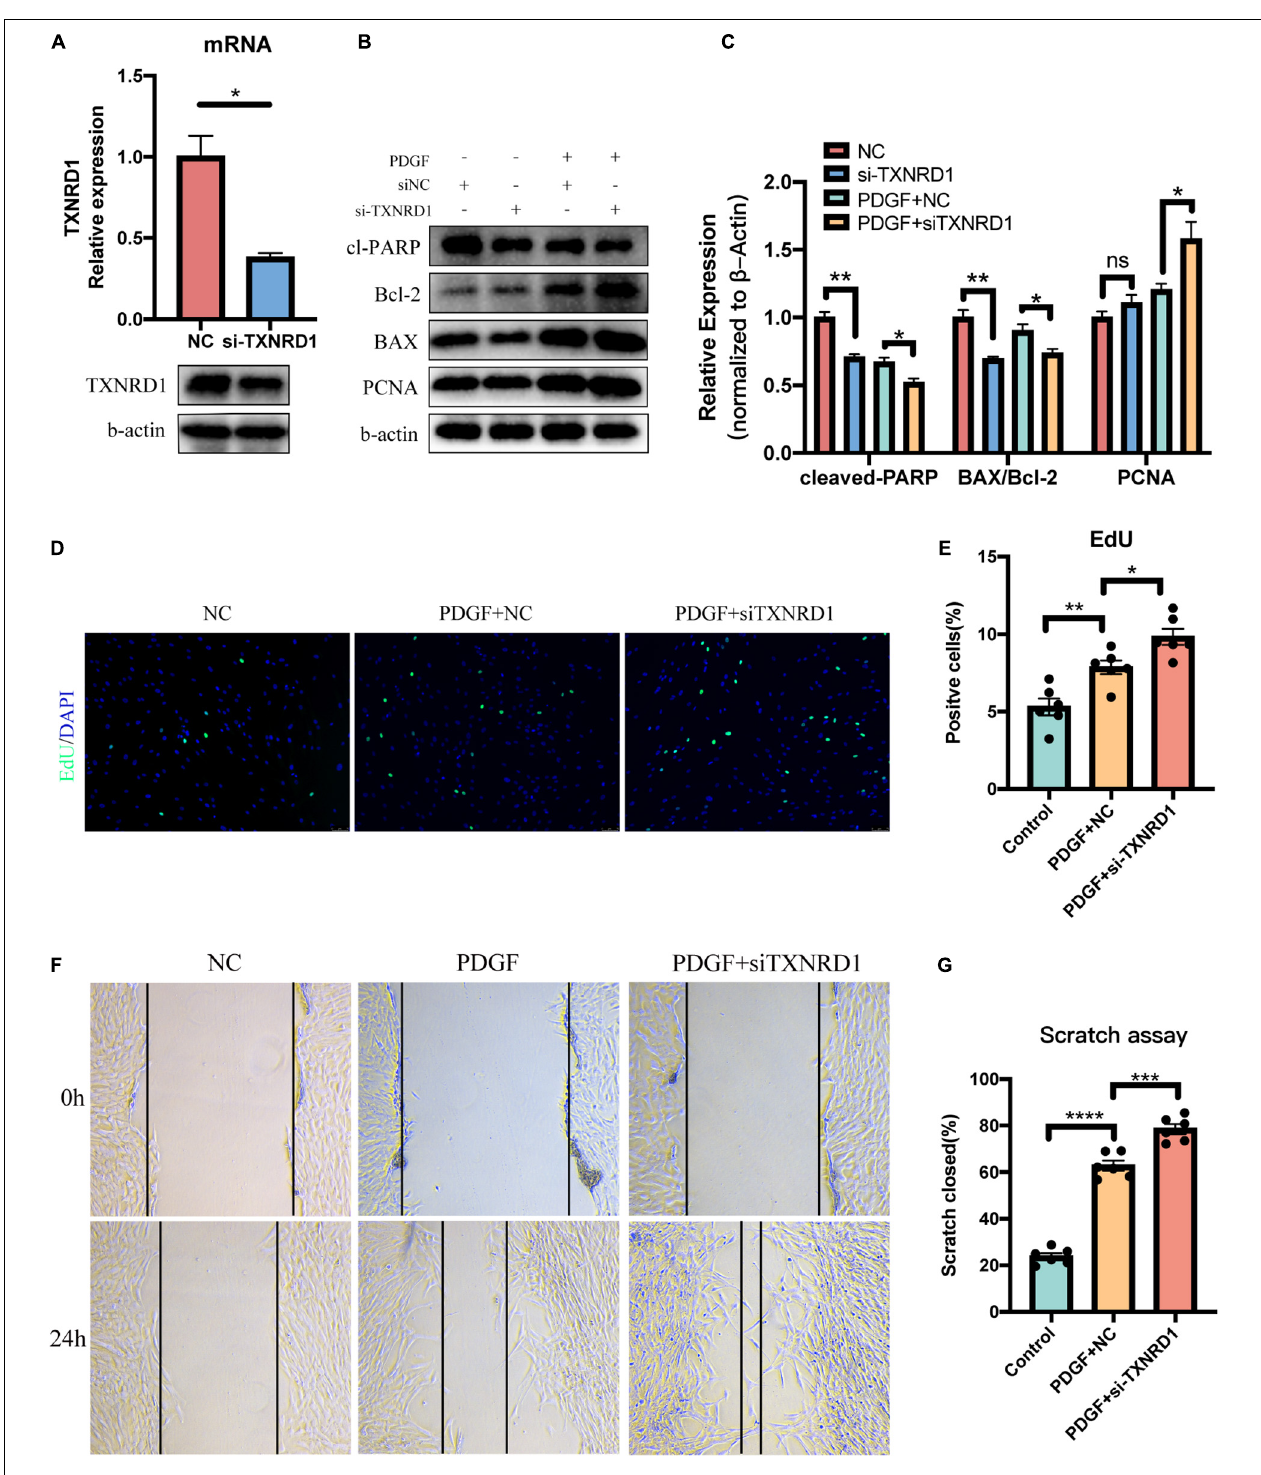
FIGURE 7 | Silencing of TXNRD1 exacerbated PDGF-induced PASMC malignant phenotype. (A) Knockdown efficiency of TXNRD1 was verified by qPCR and Western Blot. (B) PASMCs were transfected with siRNA for 48 h before treatment with PDGF-BB (20 ng/ml) for another 24 h, and western blotting was used to detect proliferative and apoptotic markers in cell lysates. (C) Normalized quantification of cleaved-PARP, BAX/Bcl-2 and PCNA expression ( n = 3 each, * P < 0.05). (D) Cell proliferative ability was determined by EdU assay in siTXNRD1-PASMC under PDGF stimulation. (E) Calculation of EdU-stained cells rate ( n = 6 each, * P < 0.05). (F) Cell migration was measured by scratch assay in siTXNRD1-PASMC under PDGF stimulation. (G) Calculation of scratch closed percentage ( n = 6 each, * P < 0.05). Data represent the mean ± SEM. Student t -test and one-way ANOVA were used to compare two and multiple groups. ** P < 0.01, *** P < 0.001,**** P <